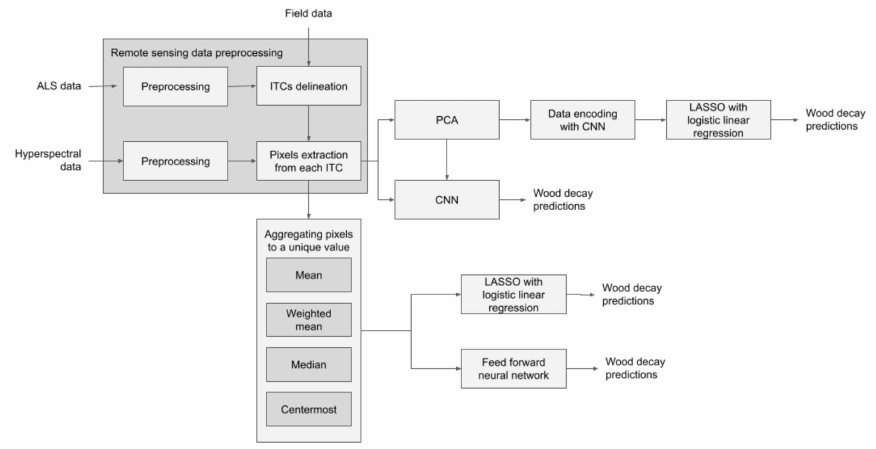
Figure 3. Overview of the methods